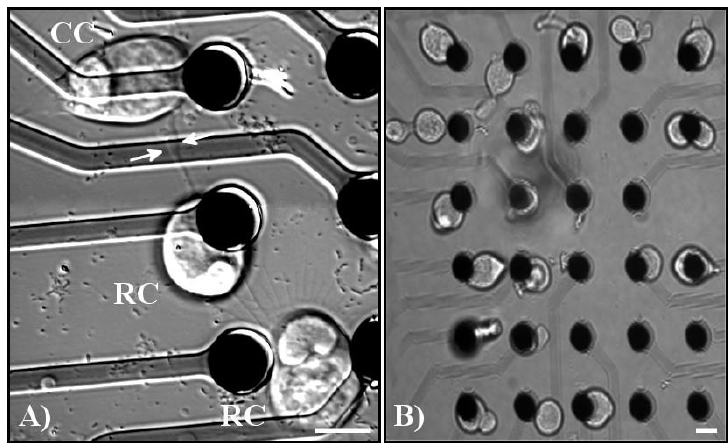
Figure 5. ( A ) Example of varicosity formation and network formation amongst tweezed cells. Pictured from top to bottom: cone photoreceptor (CC), rod photoreceptor (RC), and a rod photoreceptor. White arrows indicate the base of a varicosity extending from the middle rod photoreceptor to the neighboring cone photoreceptor. All three cells contacted each other through processes formed by the cells. ( B ) Example of groups of cells tweezed onto MEA electrodes demonstrating the precision that can be accomplished by using the MEA. From left to right, the first column of electrodes contains rod and cone photoreceptors, the second column of electrodes contains bipolar cells, the third column of electrodes contains multipolar cells, the fourth column contains bipolar cells, and the fifth column contains photoreceptors. Scale bars = 10 µm.